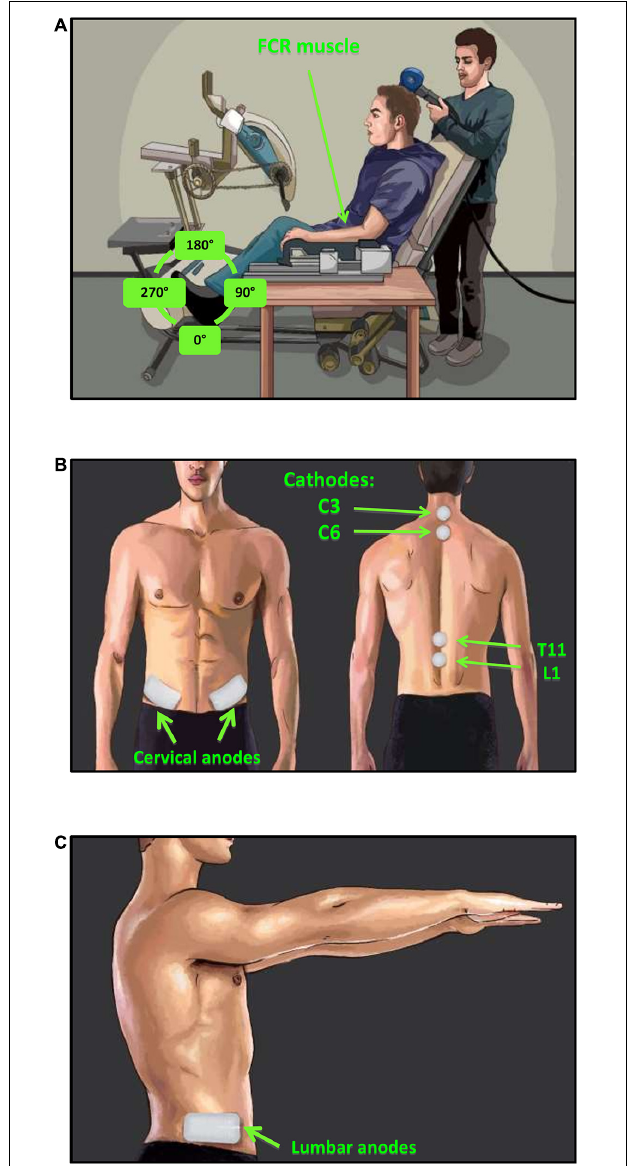
FIGURE 2 | Experimental setup and tSCS electrode placement. (A) H-reflexes were evoked via stimulation of the median nerve and recorded in the FCR muscle during a consistent baseline contraction of 5–10% maximum voluntary force (MVF). MEPs were evoked via TMS of the motor cortex and recorded in the FCR muscle during consistent baseline contraction of 5–10% MVF. (B) tSCS was delivered via two 2.5 cm round cathodic electrodes placed midline at C3–4 and C6–7 (cervical) or T11 and L1 (lumbar) spinous processes. Two rectangular anodic electrodes were placed bilaterally over the iliac crests, (C) in addition, two extra anode electrodes were place laterally beside the first two to accommodate simultaneous cervical and lumbar tSCS